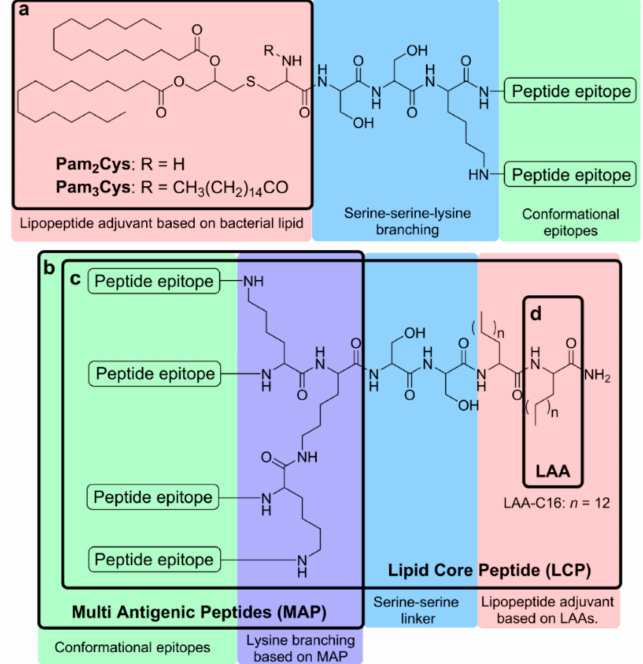
Figure 2. Schematic representation of lipopeptide-based vaccines bearing ( a ) Pam 3 Cys and Pam 2 Cys, ( b ) a lipid core peptide (LCP) system, ( c ) a multiple antigen peptide (MAP) system, and ( d ) lipoamino acids